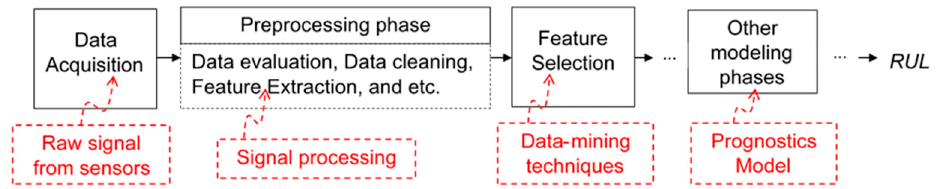
Figure 3. Role of feature extraction and feature selection in the prognostics modeling process.